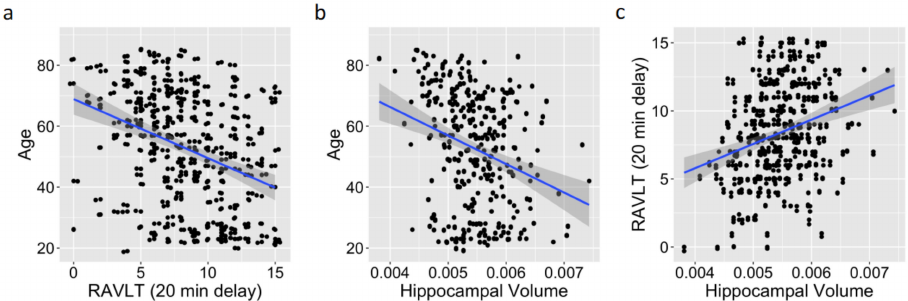
Figure 1. Replication of known bivariate relationships between age, hippocampus, and memory scores, showing replications of known bivariate relationships: a negative relationship between age and memory performance (e.g., RAVLT delayed memory) ( a ), a negative relationship between age and hippocampal volume ( b ), and a positive relationship between memory performance (e.g., RAVLT de- layed memory) and hippocampal volume ( c ). Data from the full age range of our sample (19–85 years) are depicted.